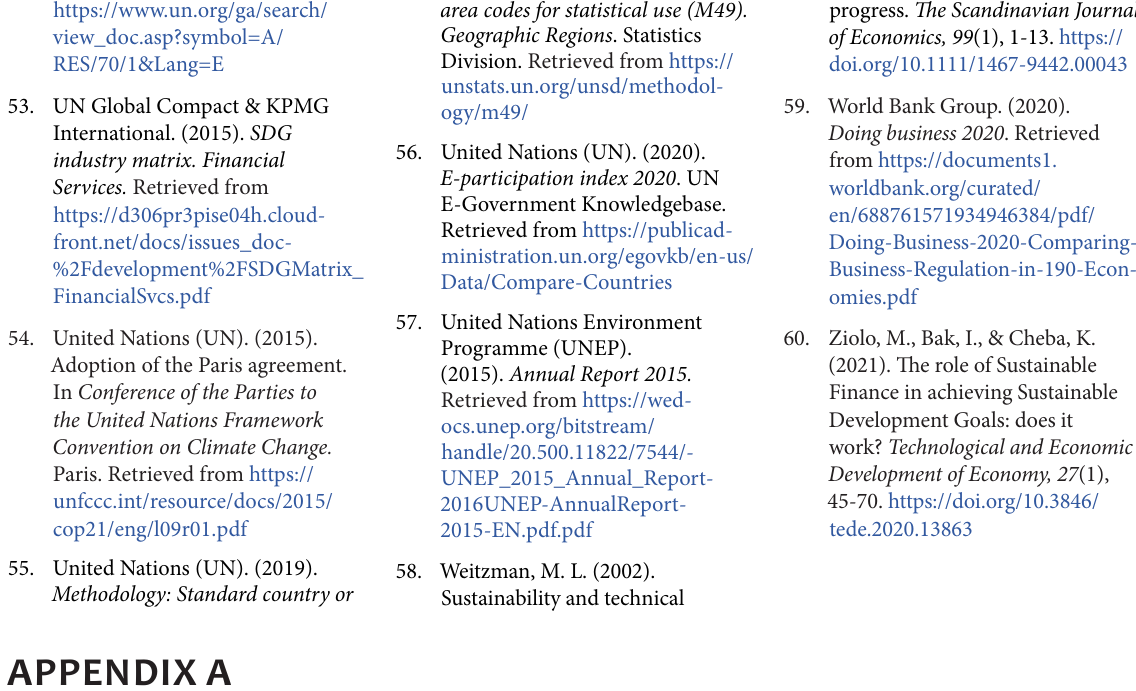
Table A1. Assessment tool for FinTech sector environment based on PEST analysis of FinTech sector external environmental